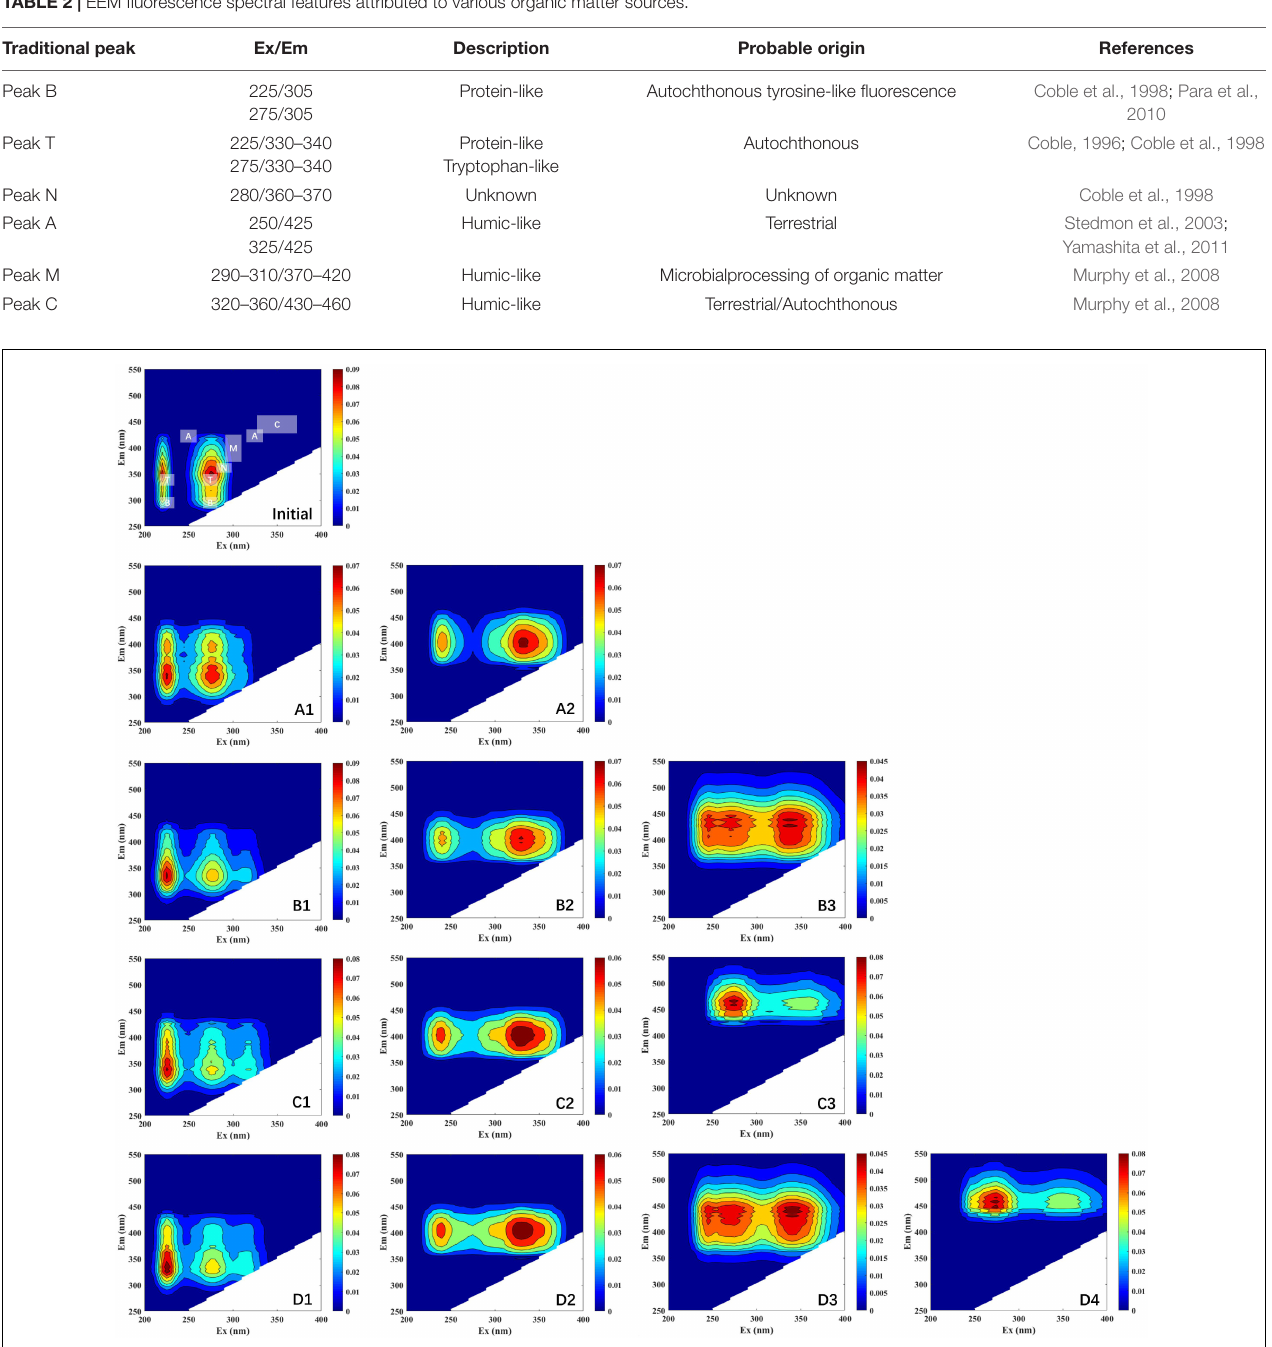
FIGURE 2 | EEM plots of the fluorescence components identified by PARAFAC model. Initial, initial component and intensity; (A1–A2) , LL group; (B1–B3) , LH group; (C1–C3) ; HL group; (D1–D4) , HH group. Different scales of Raman units (RU) are used to characterize the fluorescence